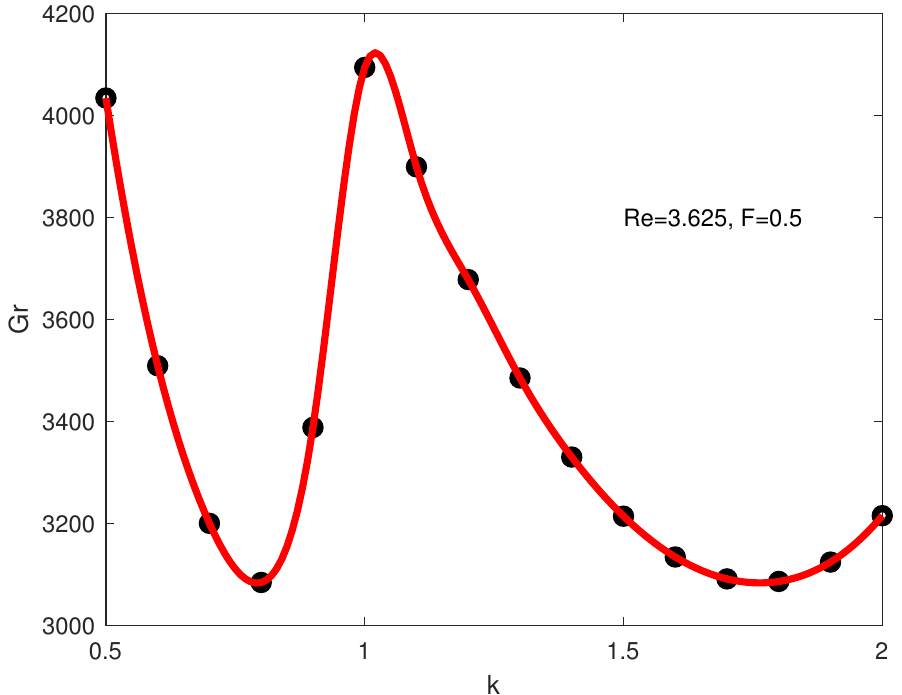
Figure 4. Marginal stability curves for F = 0.5, η = 0.6 and Re = 3.625...